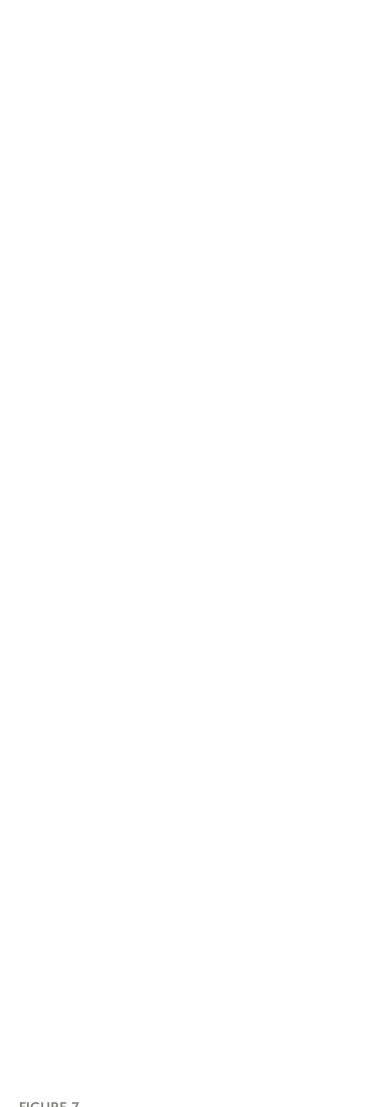
FIGURE 7 Correlation between the expression levels of ZWINT gene and immune cell in fi ltration in pan cancer. (Red to blue color represents high to low expression